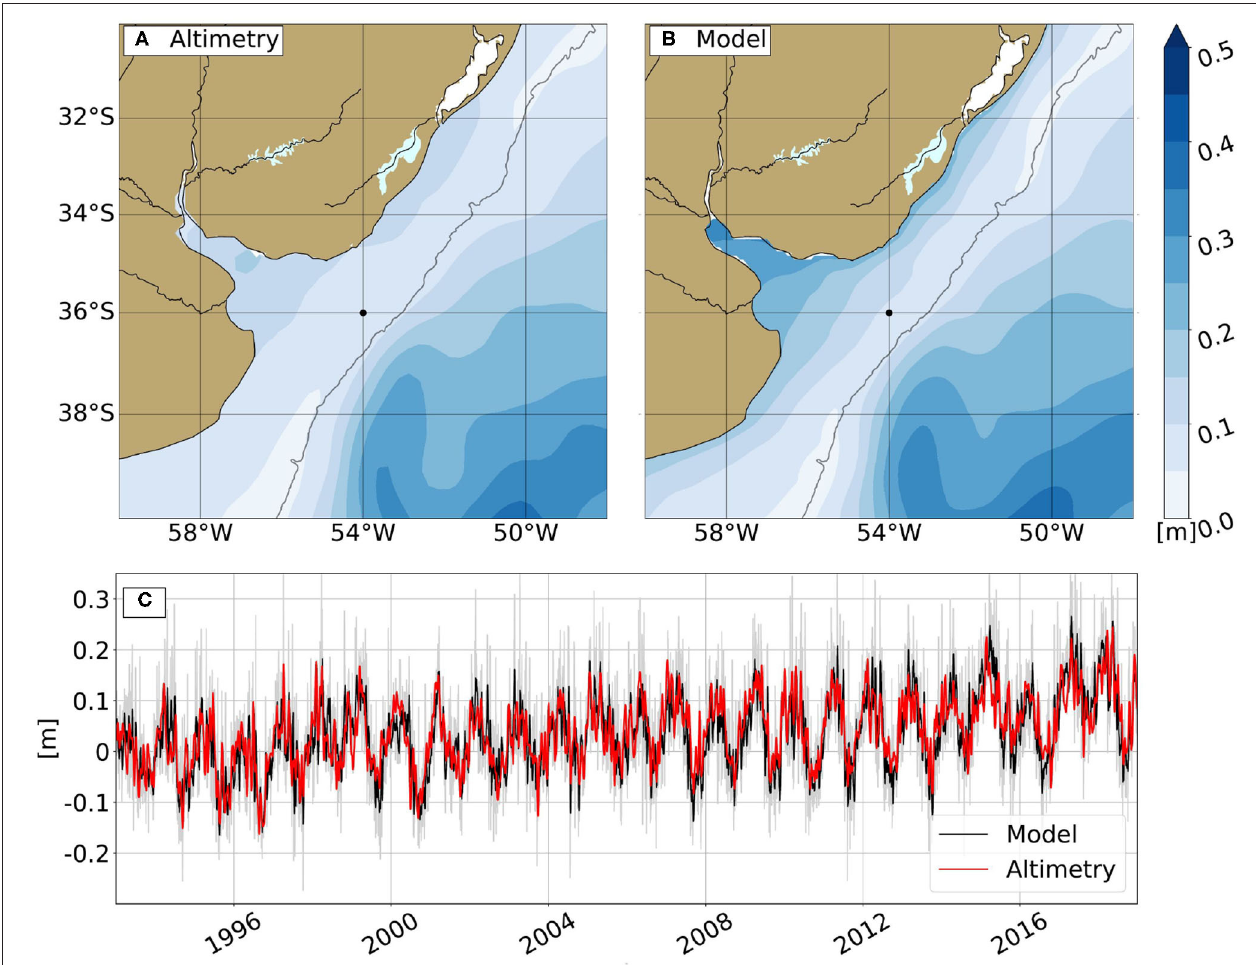
FIGURE 3 | Standard deviation of sea level anomaly based on satellite altimetry (A) and the model (B) . The 200 m isobath is indicated by a gray line. (C) Ten-day filtered time series of SLA at 36 ◦ S, 54 ◦ W (black dot in A,B ). Altimetry data is shown in red and model data in black. The daily (unfiltered) model output is shown in gray.